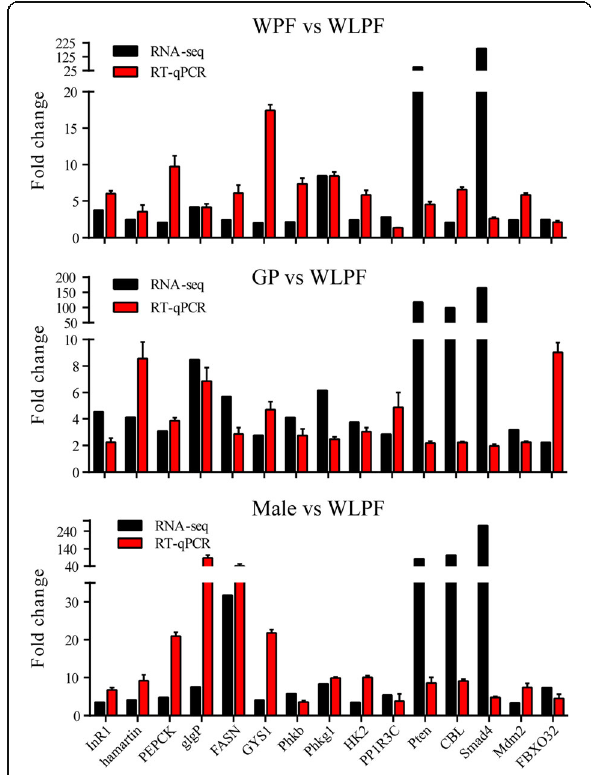
Fig. 7 Upregulated DEGs associated with insulin signaling pathway in the winged morphs. A total of 15 upregulated genes related to the insulin signaling pathway were observed with similar expression profiles between RT-qPCR and RNA-Seq results in the pairwise comparison between the winged and wingless morphs. Each value is the mean of four replicates, and error bars indicate SEs. InR1 , insulin receptor 1; PEPCK , phosphoenolpyruvate carboxykinase, cytosolic [GTP]-like; glgP , glycogen phosphorylase-like; FASN , fatty acid synthase; GYS1 , glycogen synthase; Phkb , phosphorylase b kinase regulatory subunit beta; Phkg1 , phosphorylase b kinase gamma catalytic chain; HK2 , hexokinase-2; PP1R3C , protein phosphatase 1 regulatory subunit 3C; Pten , phosphatidylinositol 3,4,5-trisphosphate 3-phosphatase and dual-specificity protein phosphatase; CBL , calcineurin B-like; Smad4 , mothers against decapentaplegic homolog 4; Mdm2 , E3 ubiquitin-protein ligase Mdm2; and FBXO32 , F-box only protein 32. Fold change, the